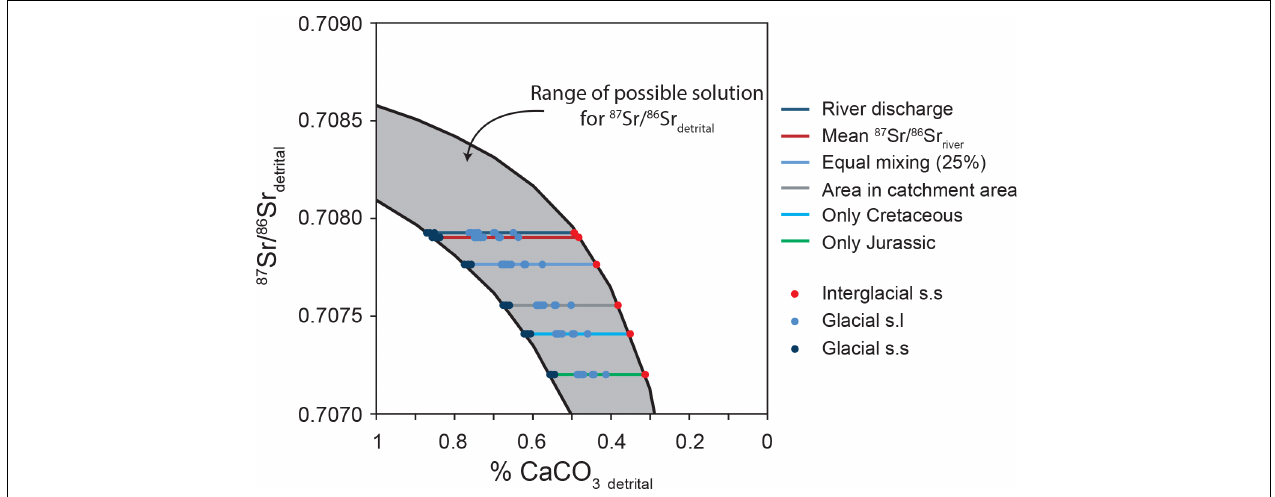
FIGURE 4 | Modeled mixing of a two components system with end-members representing marine biogenic carbonates ( 87 Sr/ 86 Sr = 0.7092) and an unknown detrital source. The black lines are the predicted 87 Sr/ 86 Sr of the detrital end-member that satisfy the isotopic mass balanced, using the 87 Sr/ 86 Sr of the less (bottom boundary) and more (upper boundary) radiogenic PRGL1-4 samples. The gray shaded area shows the range of possible solutions according to the weight percentage of detrital carbonate in the sediment mixing. Colored horizontal bars represent possible detrital isotopic composition based on mean river discharges (dark blue line), mean 87 Sr/ 86 Sr riverbeds composition (dark red line), exposed surface area in the catchment area (gray line), 87 Sr/ 86 Sr of Cretaceous rocks (cyan line), 87 Sr/ 86 Sr of Jurassic (green line), and equal mixing ratio between carbonated rocks within the catchment area (light blue). Circles represent % of detrital carbonates in order to obtain the observed 87 Sr/ 86 Sr composition in PRGL1-4 sediment during glacial sensu stricto and sensu lato (i.e., dark and light blue circles, respectively), and interglacial sensu stricto (i.e., red